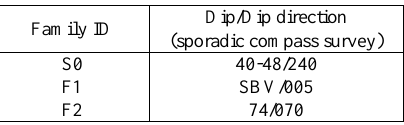
Table 3. Compass reading of the orientation of three discontinuity families for the Saulges cliff